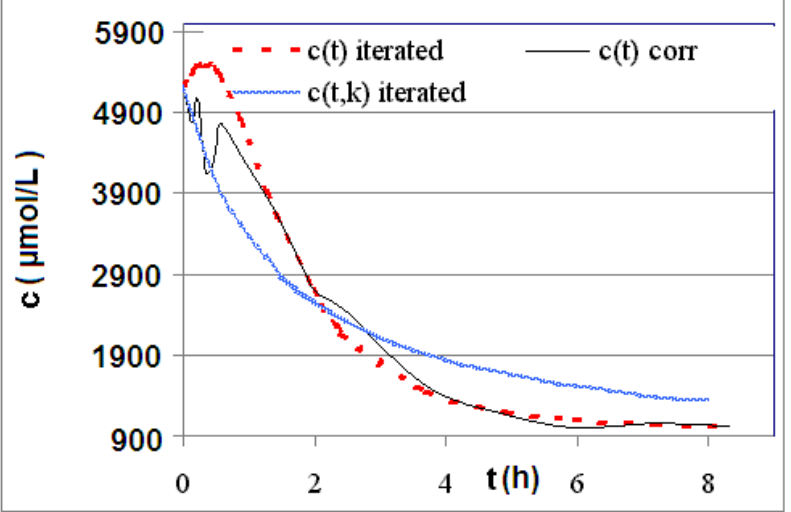
( t ) /c ( t ) /c ( t,k ) only for educt thiol corr iterated iterated